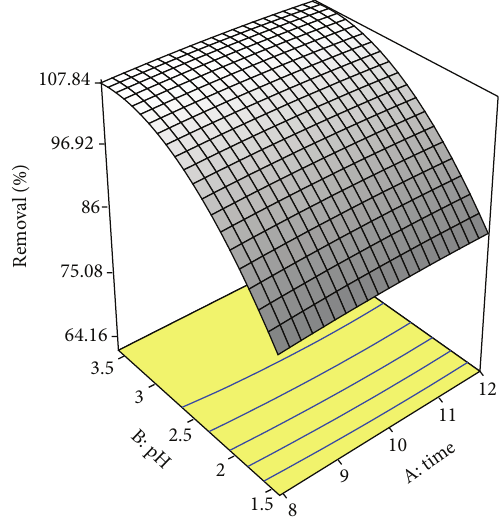
Figure 2: Response surface plot showing the effect of contact time and pH and their mutual effect on the removal of lead using tartrate- Mg-Al layered double